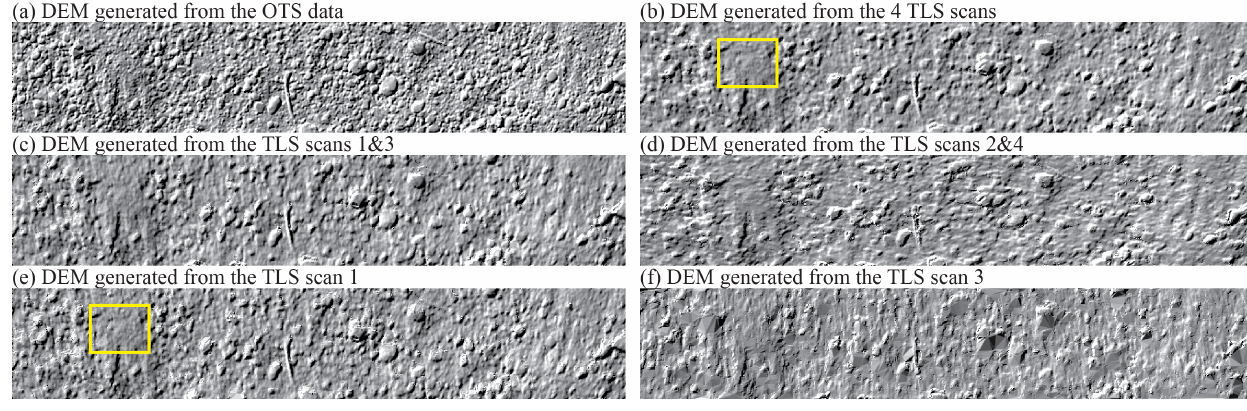
Figure 8. The six optimal DEMs for which the spectral slope was minimized and which were selected from: ( a ) Set 2.6, ( b ) Set 2.5, ( c ) Set 2.3, ( d ) Set 2.4, ( e ) Set 2.1 and ( f ) Set 2.2; The DEMs cover the area of the subplot, i.e. , 0.18 m × 1